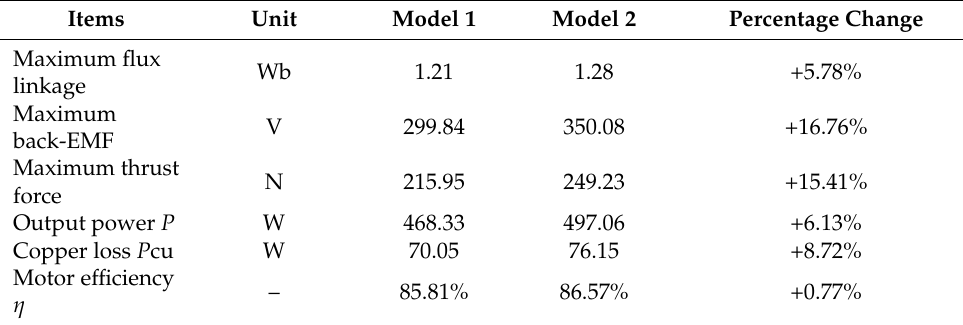
Table 2. Comparison of simulation parameters of two models.